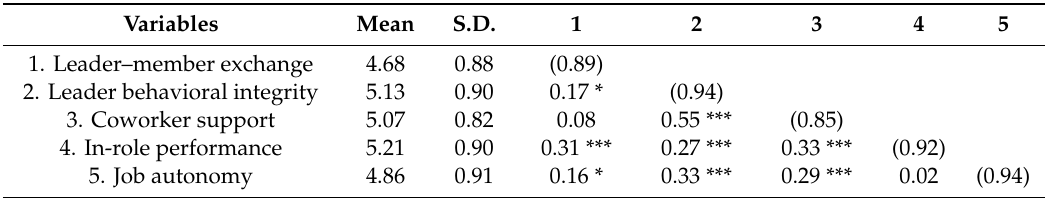
Table 1. Descriptive statistics.